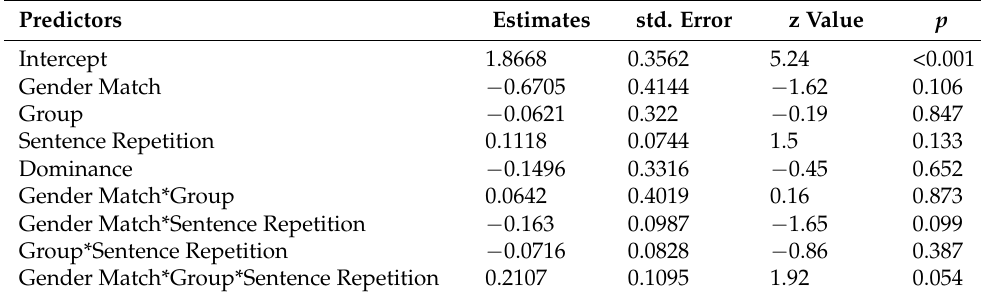
Table A7. Summary of the model for accuracy and the effect of sentence repetition and language dominance in the production task for the whole dataset.